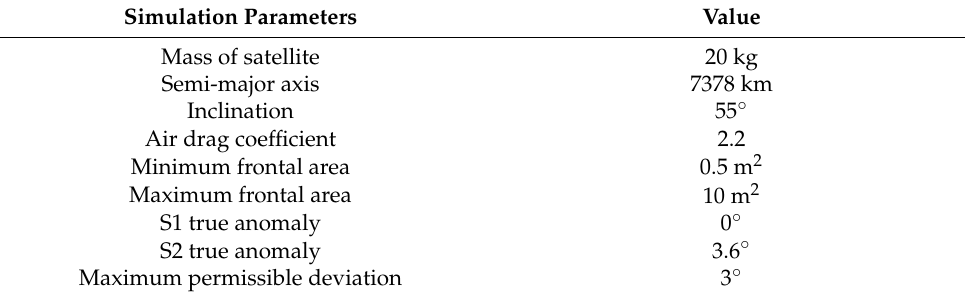
Figure 14. Iridium c onstellation access to Sydney.